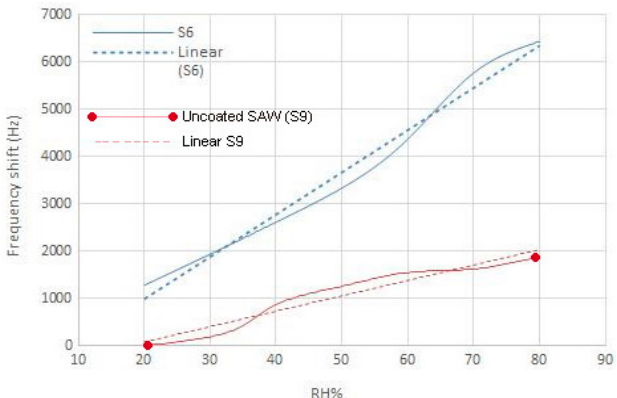
Figure 6. Sensitivity graphs of Sensor S6 and the uncoated SAW device.